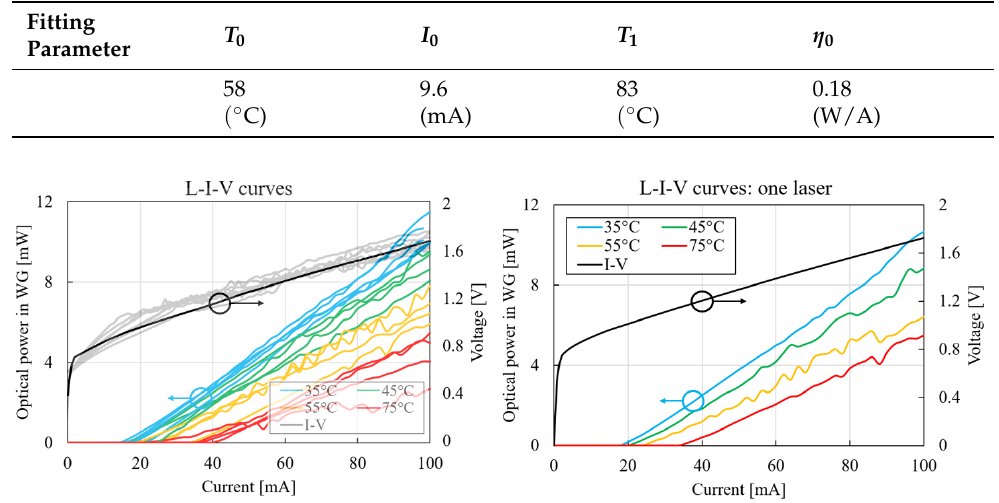
Table 1. Fitting parameters for a compact laser model extracted from experimental results.